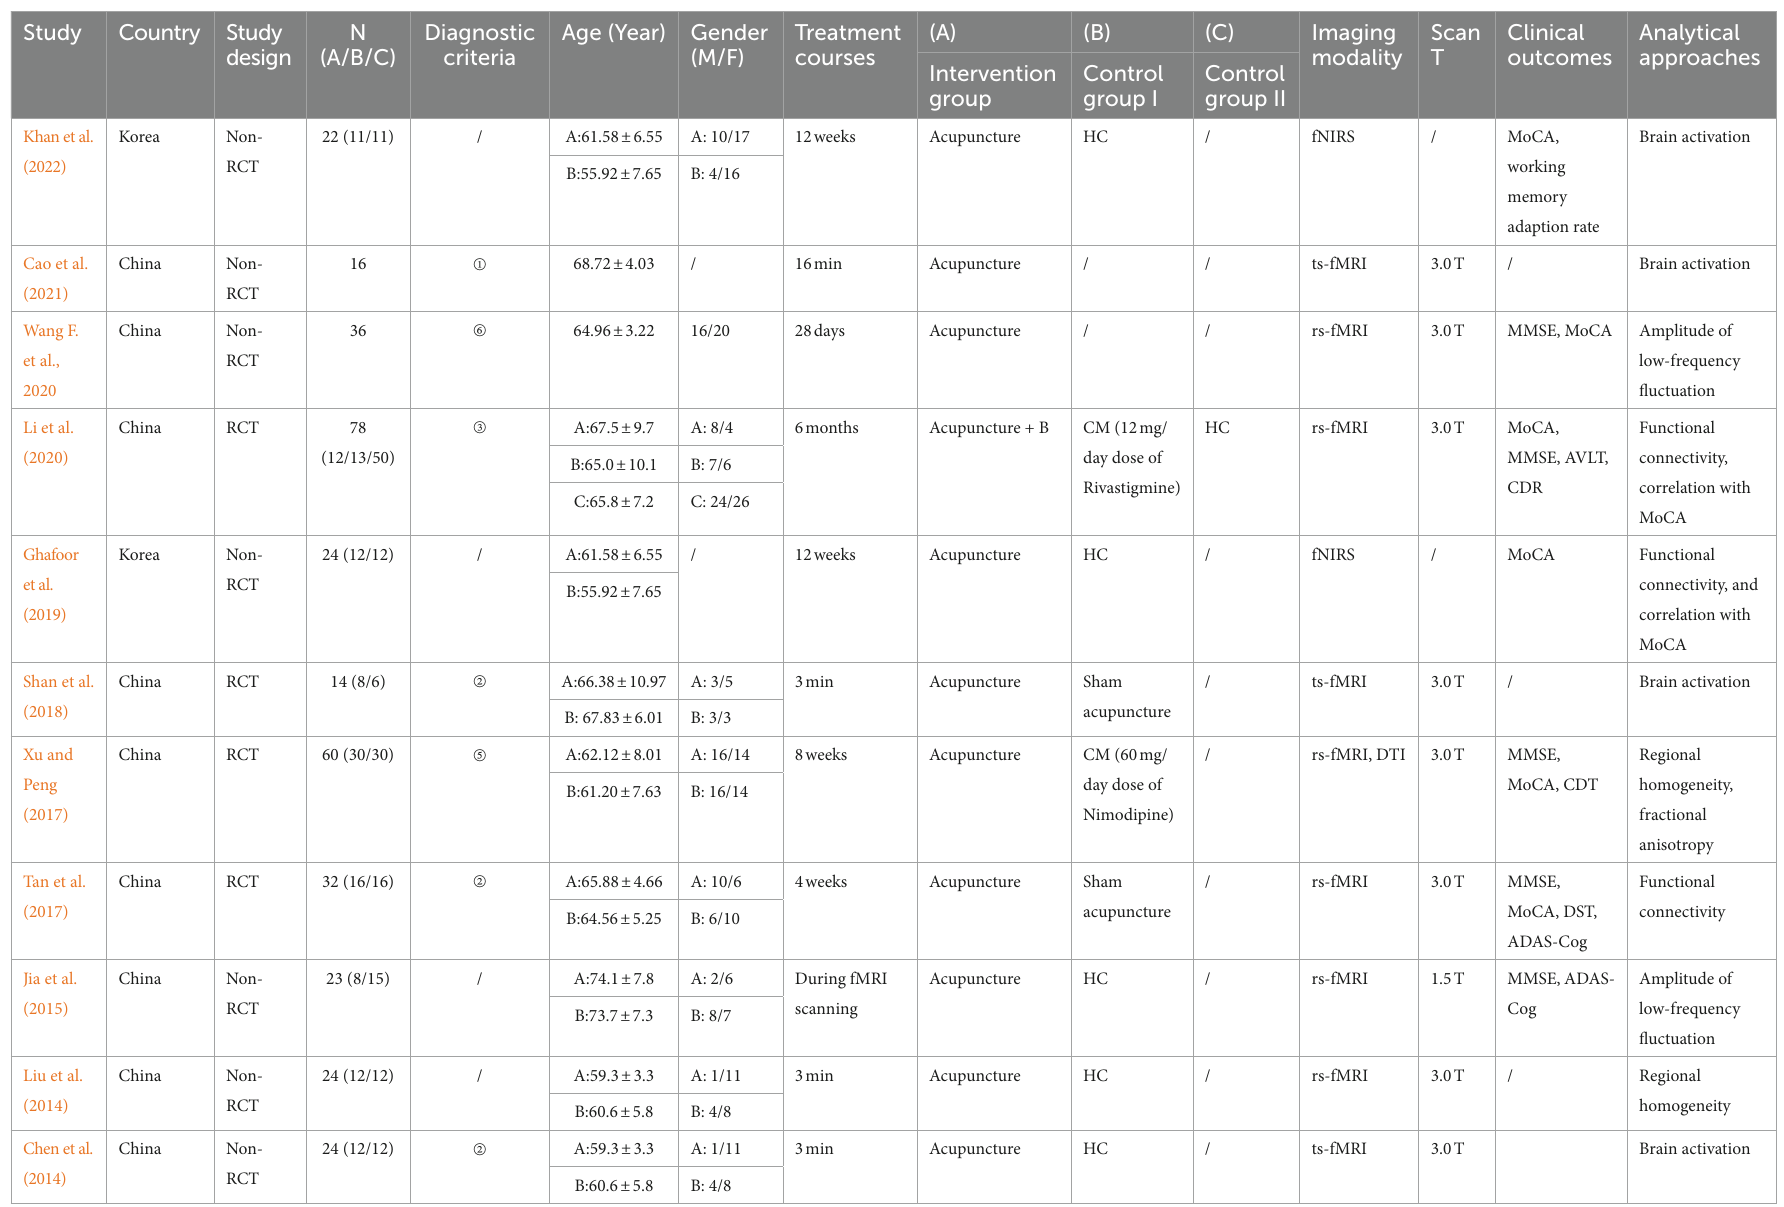
TABLE 1 Main characteristics of included neuroimaging